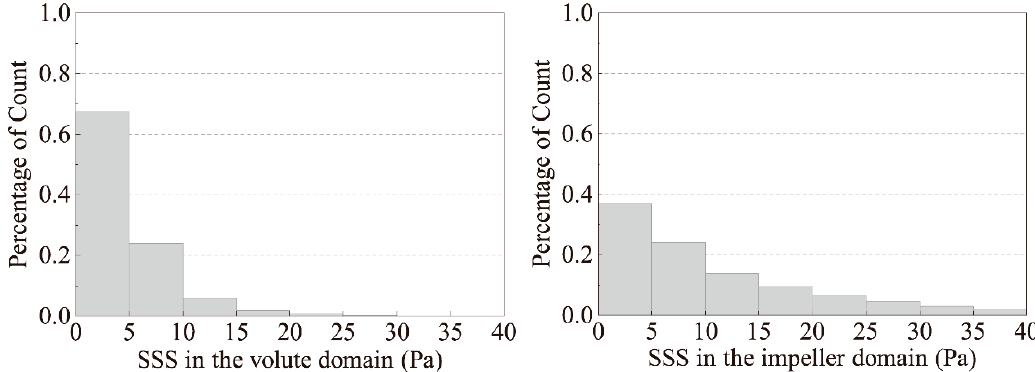
Figure 11. Probability distribution of scalar shear stress (SSS) of the model No. 10 at original design point by CFD simulation ( Q 0 = 5.0 L/min, n = 2500 r/min).